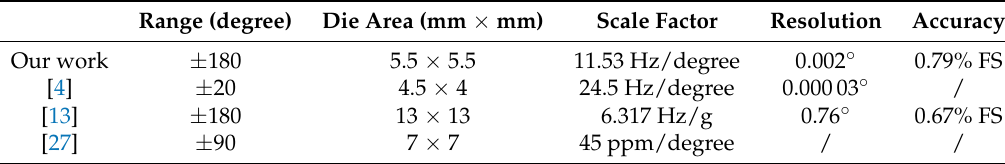
Table 3. Comparison between this work and other